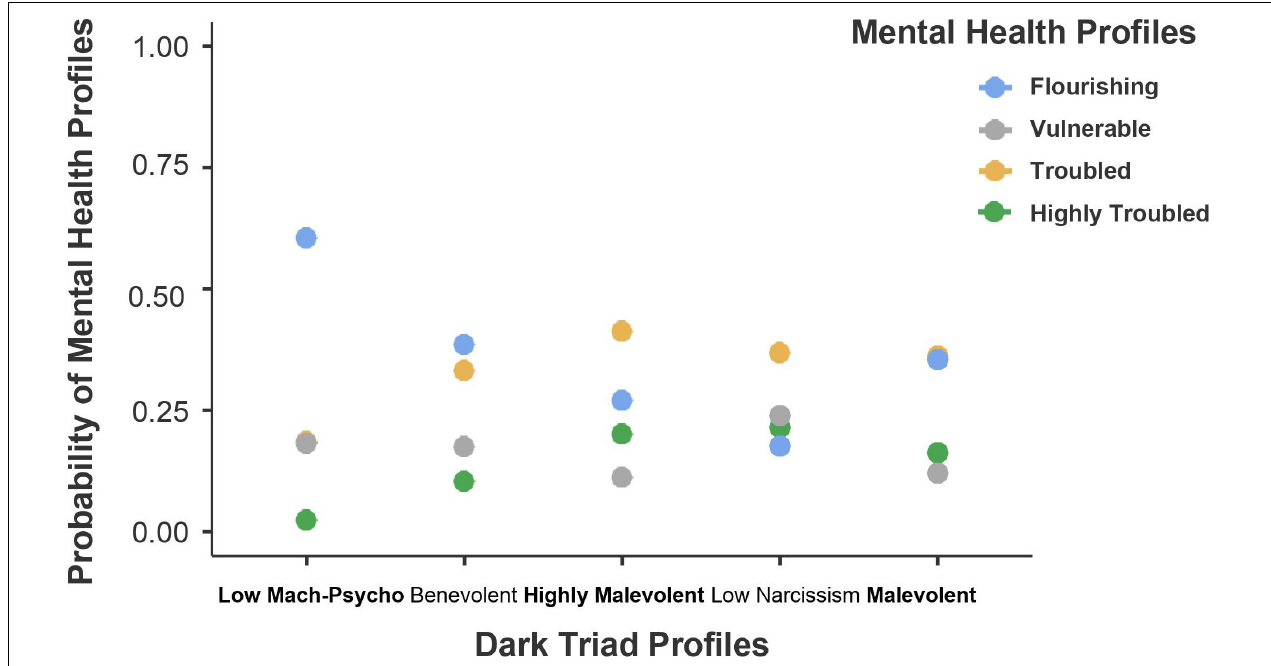
FIGURE 3 | The effect of the Dark Triad profiles on the probability of mental health profiles. N = 1,640. Mach-Psycho,